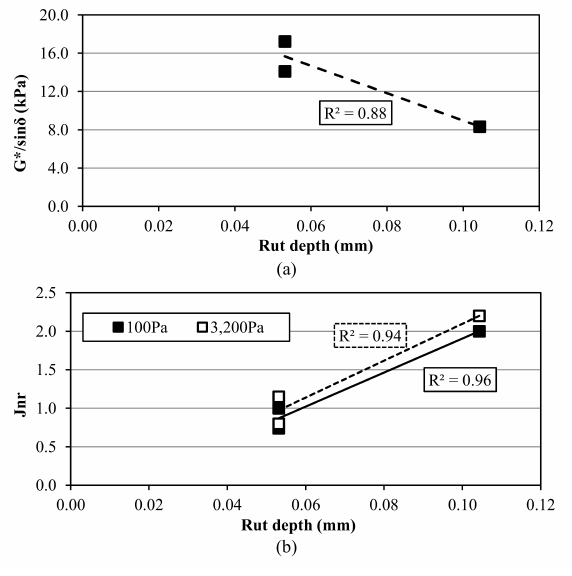
Figure 9: Comparison of rut depth with: (a) | G* | /sin δ and (b) Jnr